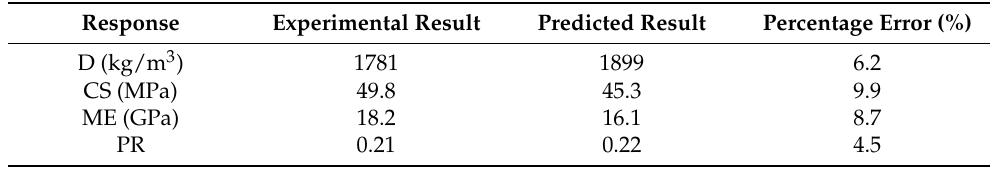
Table 6. Experimental validation